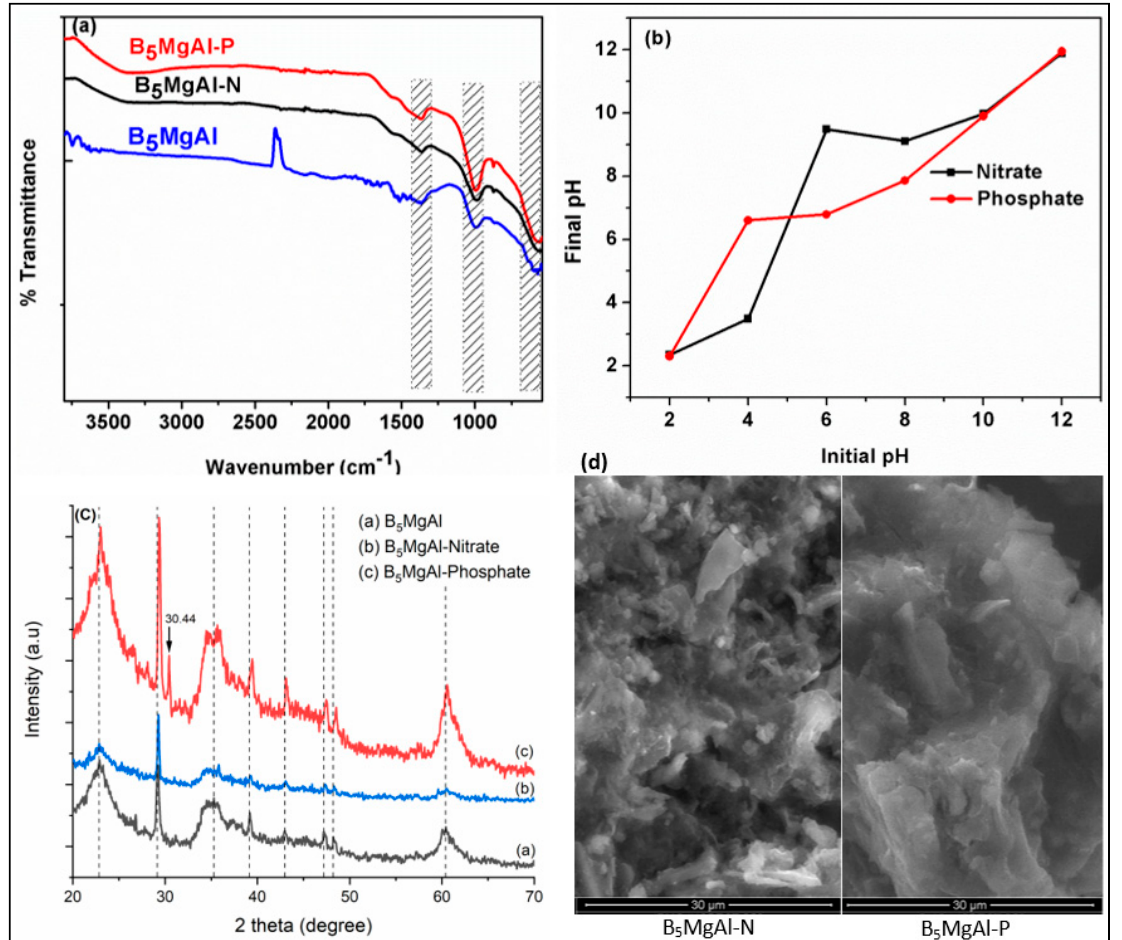
Figure 7. FTIR ( a ), pH after adsorption ( b ), XRD ( c ), and SEM images ( d ) of B 5 MgAl before and after phosphate and nitrate adsorption.